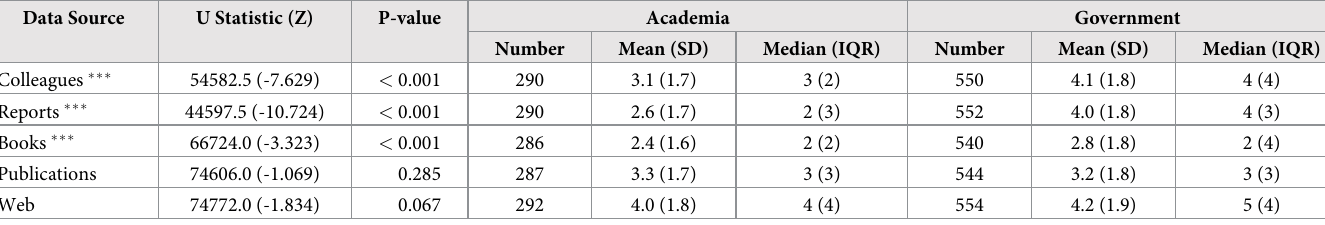
Table 9. Mann-Whitney U tests of frequency of use of different sources of species occurrence data.